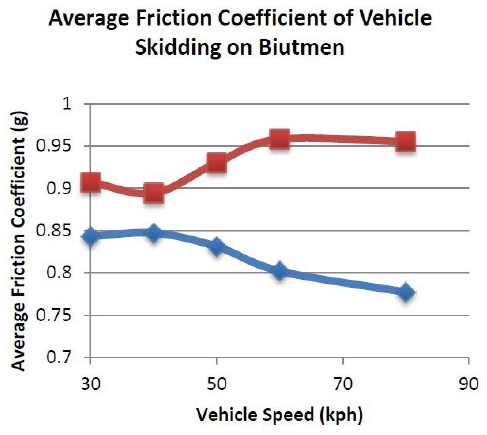
Fig. 7. Average friction coefficient of skidding vehicle with and with- out antilock braking system